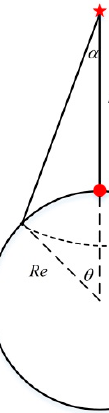
Figure 1. Diagram of the coverage region on the earth’s surface.